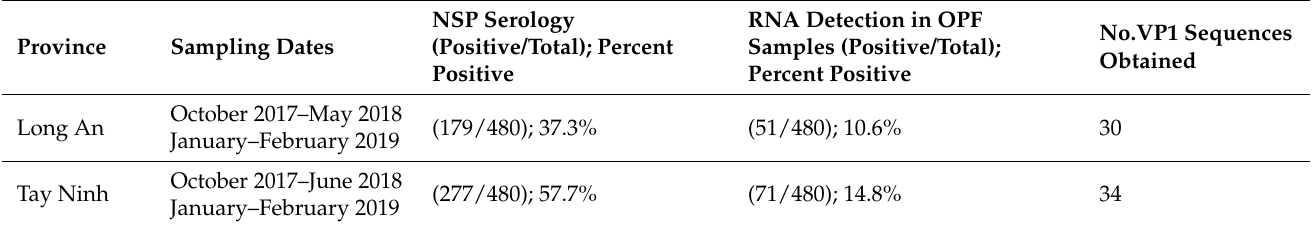
Table 2. Descriptive characterization of slaughterhouse sample screening from two slaughterhouses in southern